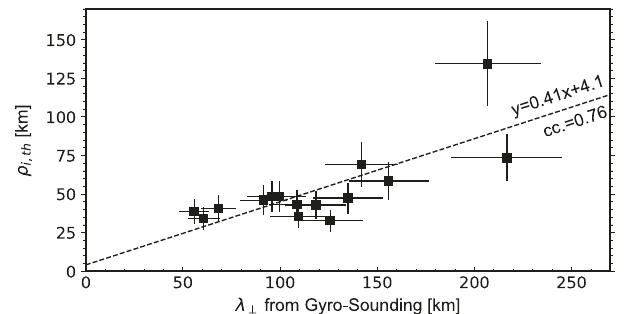
Fig. 6 | The perpendicular wavelength of fi fteen quasi-monochromatic KAW events observed by MMS. The horizontal axis corresponds to the perpendicular wavelengthderivedfromtheparticle-soundingtechnique,whereastheverticalaxis represents proton gyro-radius evaluated at local proton perpendicular thermal energy T ? (taken from the MMS/FPI/DIS-MOMS dataset). The dashed line shows a linear regression of the data, with the results denoted in the fi